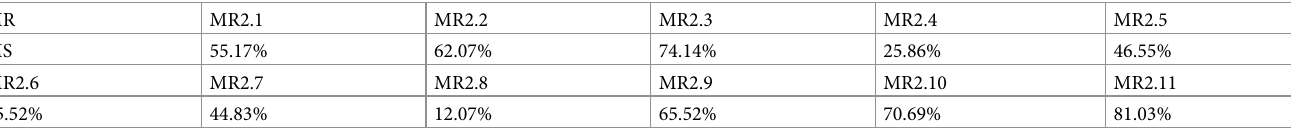
Table 7. Mutation scores of MRs for the counter deposit event for all mutants.